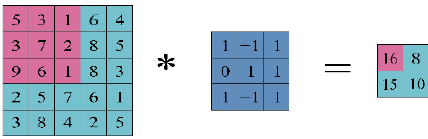
Figure 2. Convolution operation of 2DCNN.